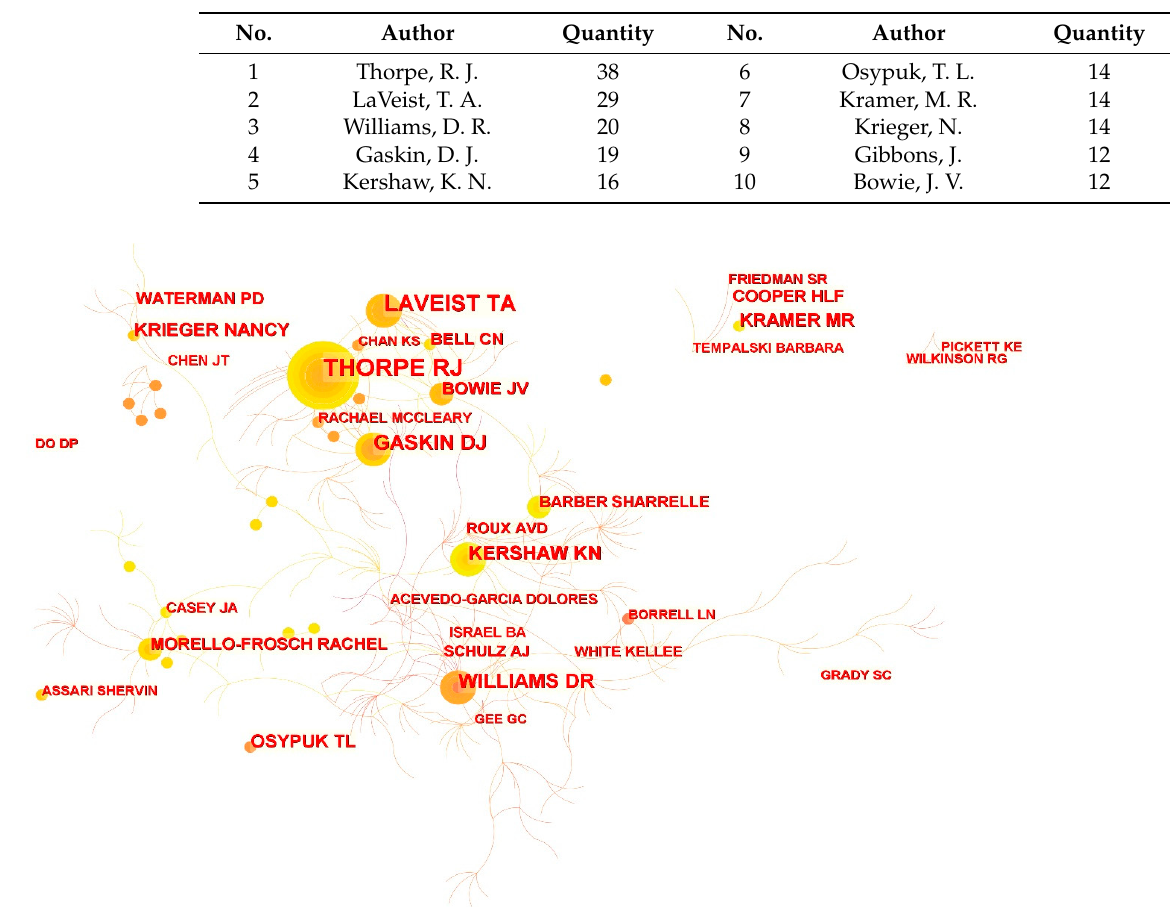
Figure 2. Network map showing authors’ collaborations in RSH research.